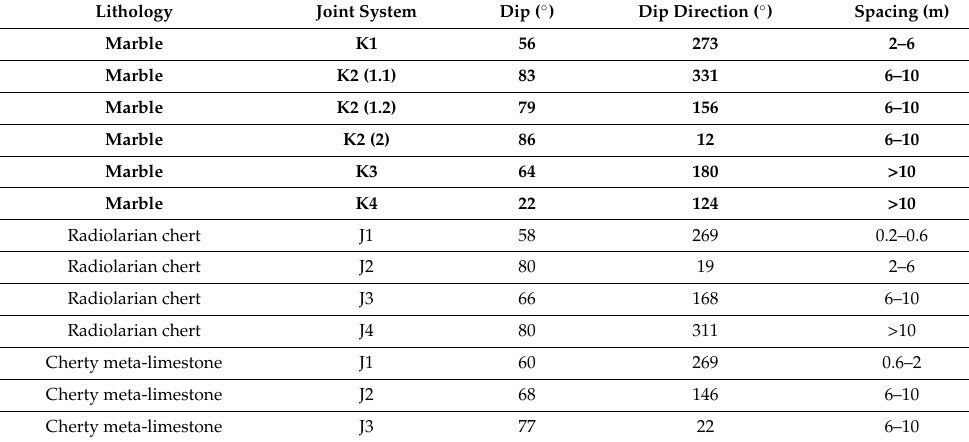
Table 1. Geometrical characteristics of joint systems [47].